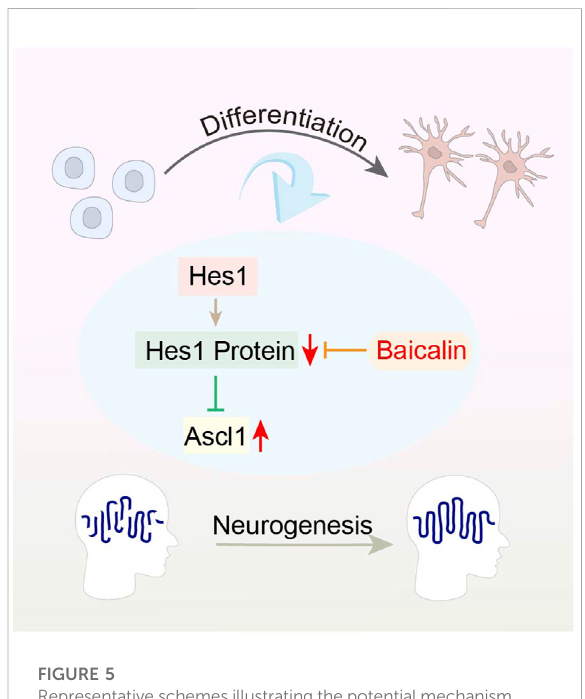
FIGURE 5 Representative schemes illustrating the potential mechanism of Baicalin regulation in the differentiation of